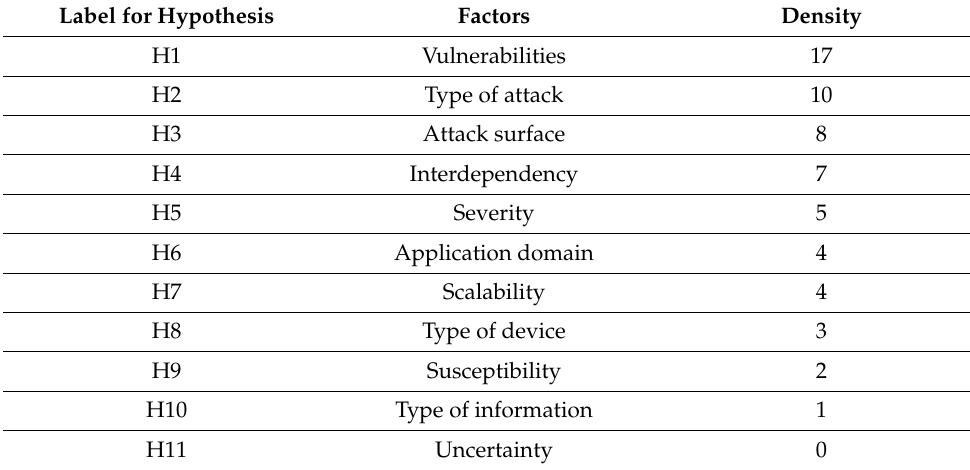
Table 3. Factors of IoT devices that could affect risk values and their values of density from the quality analysis. Label for Hypothesis